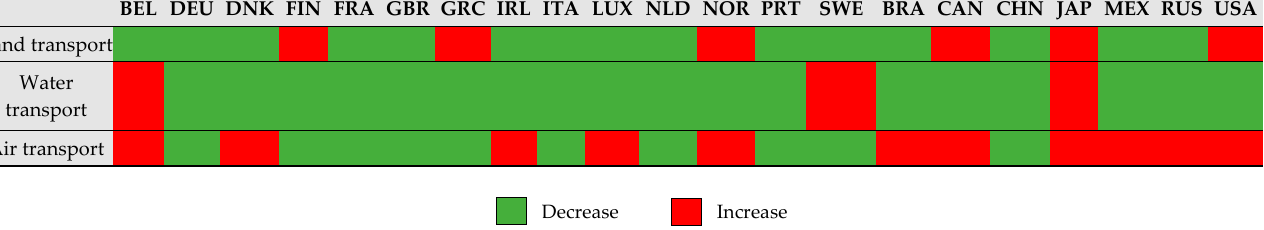
Figure A1. Difference in the CO 2 emissions coefficient by transport sector (2005–2016). Source: own preparation based on Timmer, M.P., Dietzenbacher, E., Los, B, Stehren and de Vries, G.J. (2015).